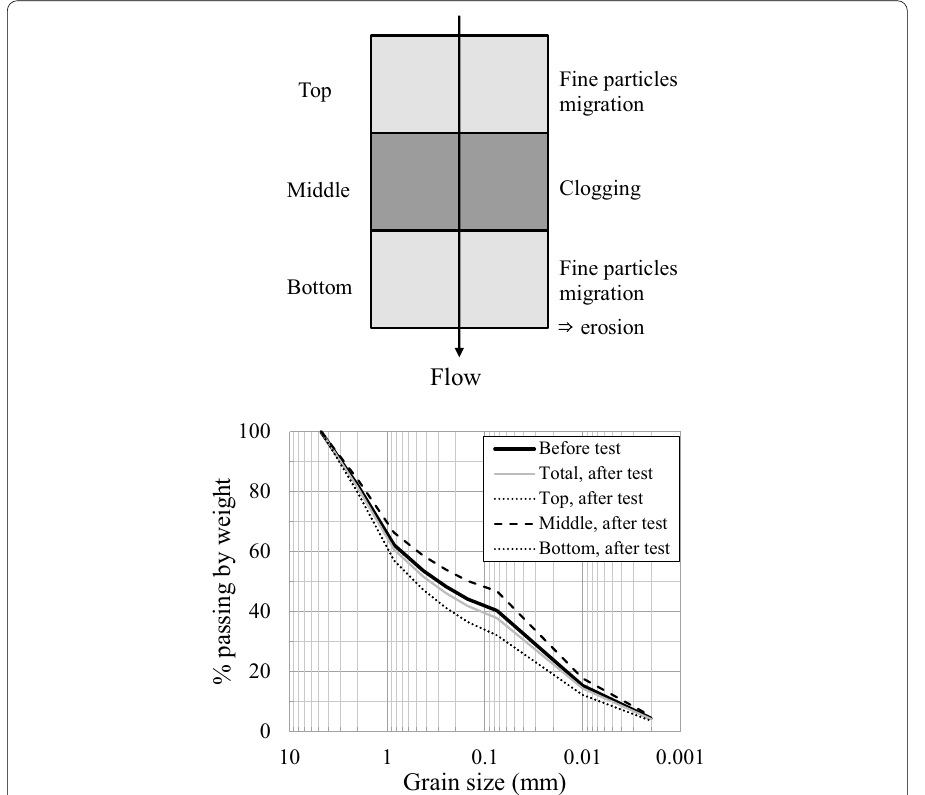
Fig. 9 Hypothetical grain size distribution based on the test results of Kim [11]